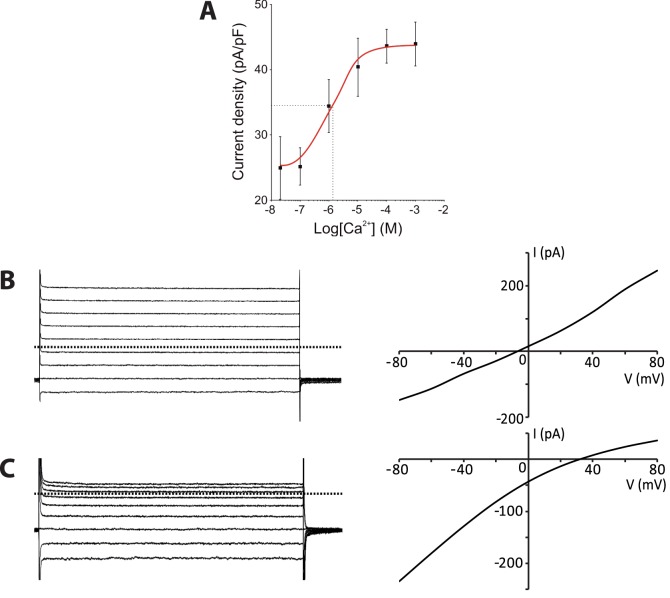
The SlitBest1b current depends on the Ca2+ concentration and is anionic. A) Dose-response recordings were conducted in a low-Cl− external solution. The curve fitted to the Hill equation has an EC50 of 1.2 µM and a Hill coefficient of 1.0. Means ± SEM. Representative currents recorded during voltage step protocols and corresponding I-V relationships from SlitBest1b transfected cells dialyzed with 100 µM intracellular Ca2+, B) in symmetrical Cl− concentrations (E
Cl = 0 mV), and C) in low-Cl− bath solution (E
Cl = 104 mV). Dotted horizontal lines are zero current levels.